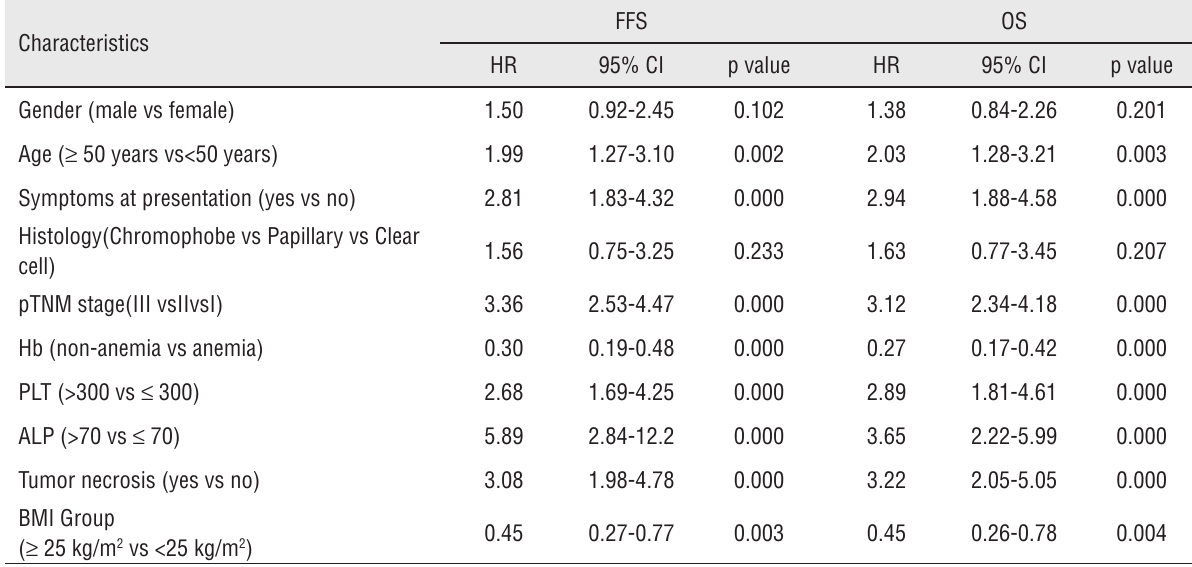
Table 2 - Pretreatment BMI Effect on Different Endpoint: univariate Analysis in Cox Regression Model. Characteristics